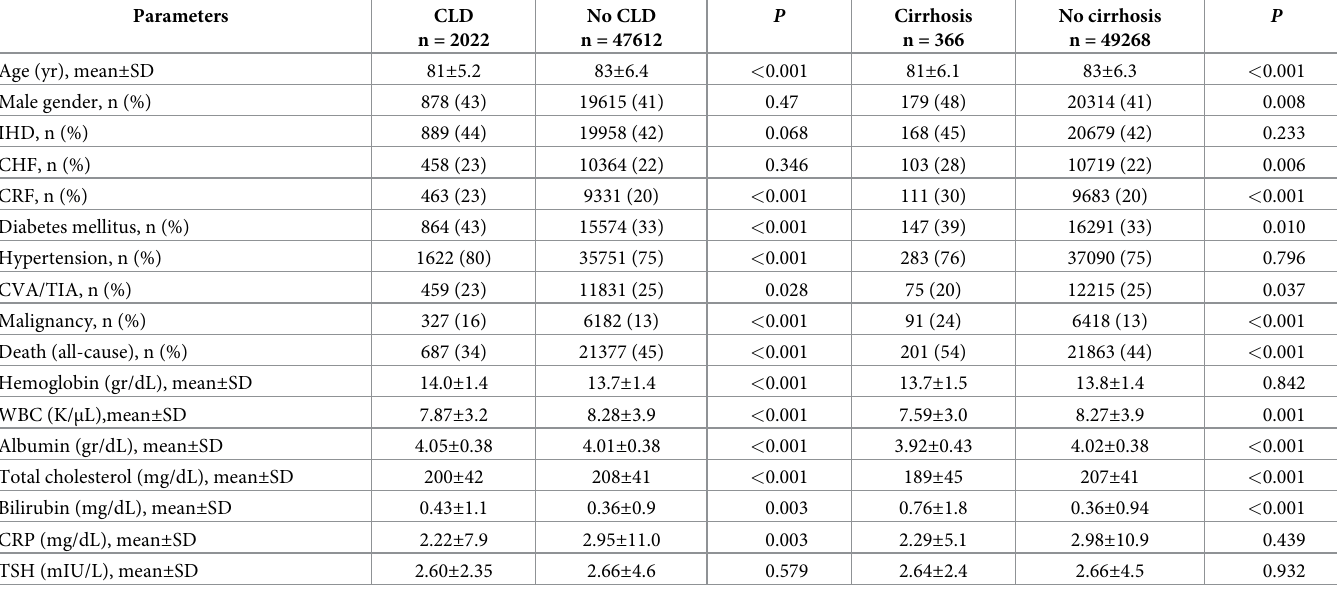
Table 1. Baseline characteristics, associated diseases and laboratory results by presence of CLD and cirrhosis (n = 49634). Parameters